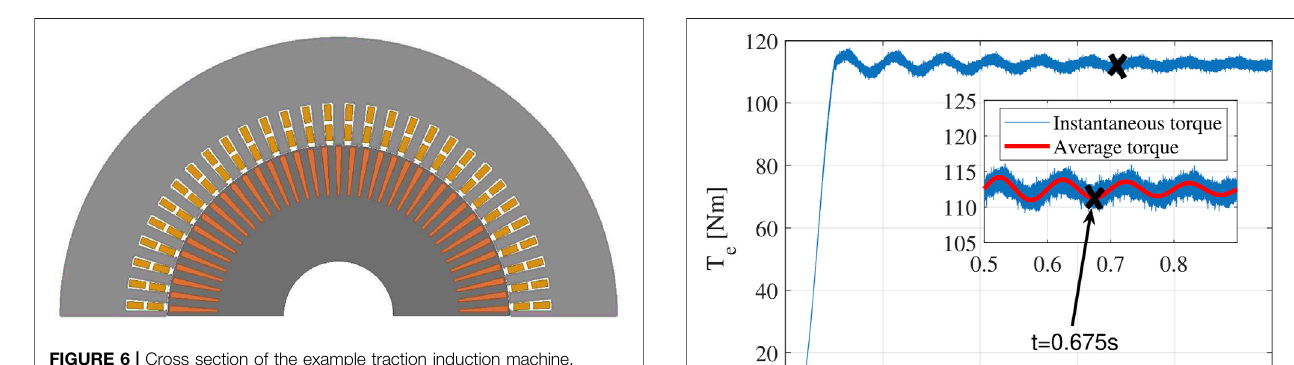
FIGURE 6 | Cross section of the example traction induction machine.